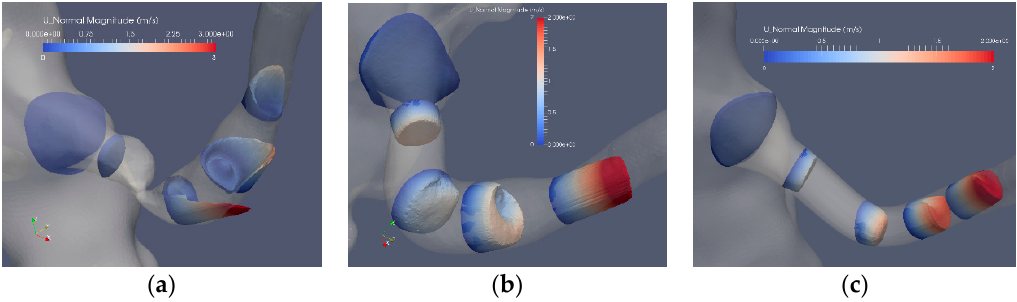
Figure 5. The axial velocity component at peak flow: stenosis (Case1.1) ( a ), Voronoi reconstructed (Case1.2) ( b ) and reconstructed sweeps (Case1.3) ( c ).